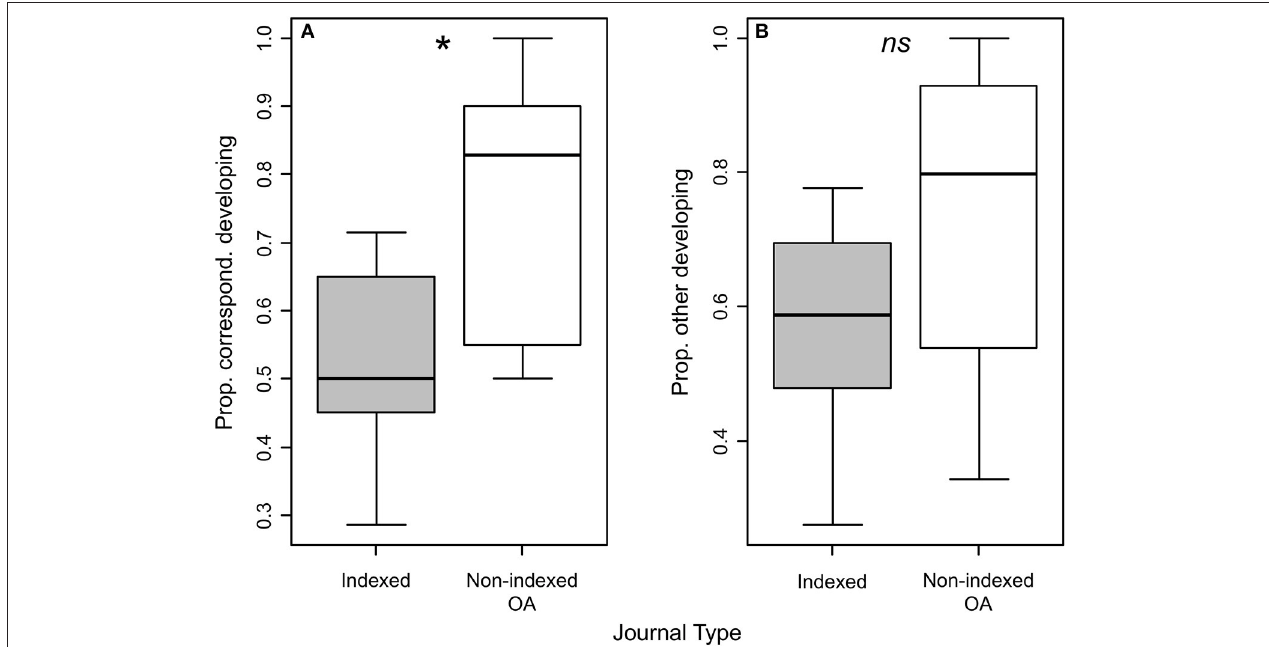
FIGURE 4 | Boxplot representation of demographic article level metrics for indexed (gray boxes) and non-indexed OA (white boxes) journals, including the proportion of articles containing corresponding authors (A) and other authors (i.e., all authors other than the corresponding author) (B) with affiliations in developing countries. Asterisks denote significant differences between journal types; ns denotes non-significant differences (see Table 4 ). n = 6 per